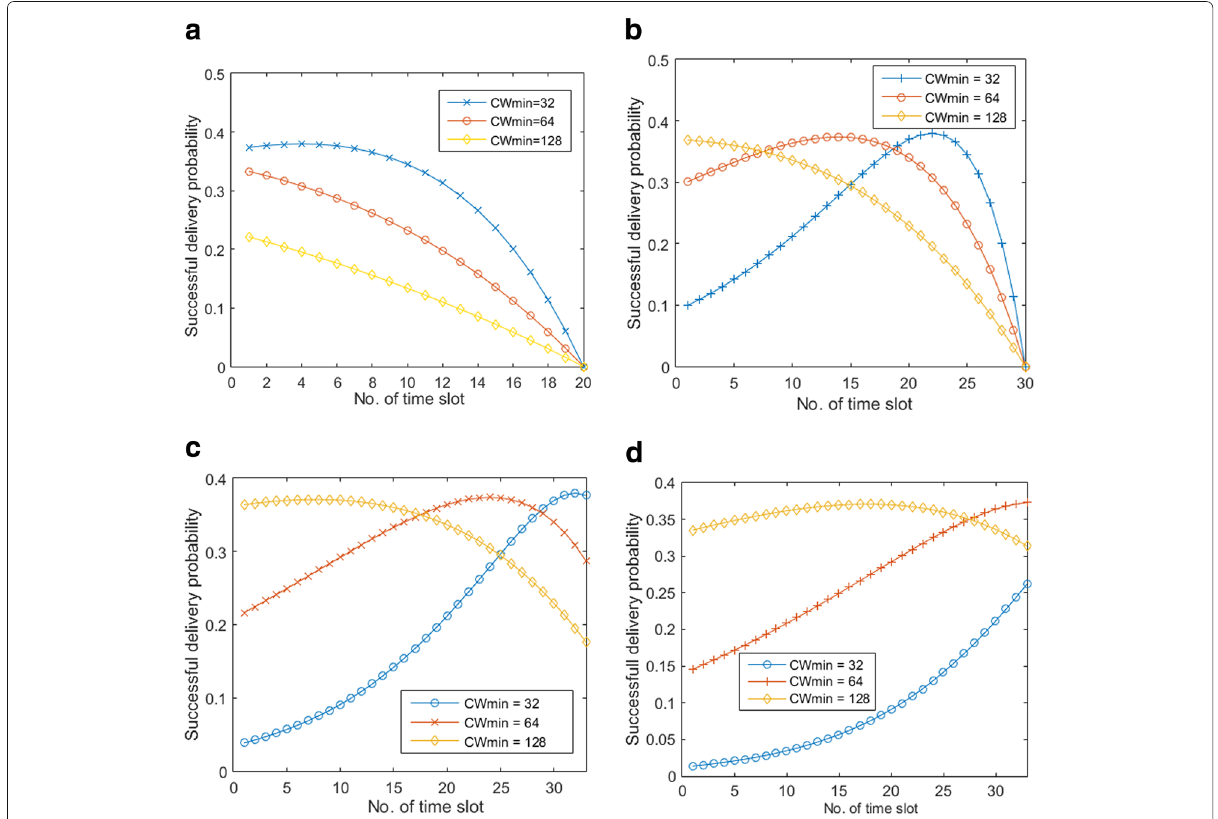
Fig. 1 a – d Successful transmission probability. a 40-node network, b 60-node network, c 80-node network, d 100-node